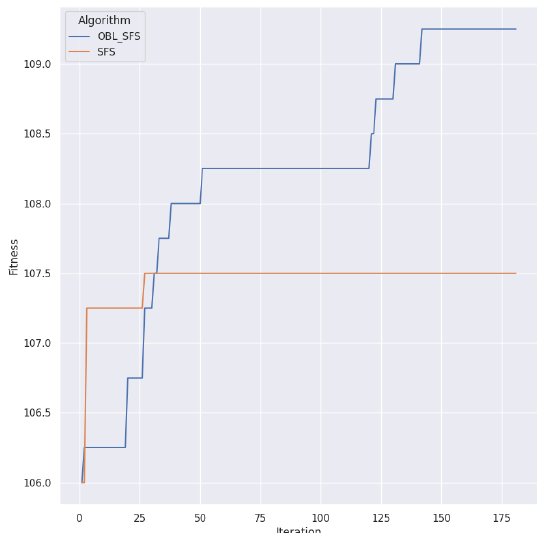
Figure 6. Fitness per